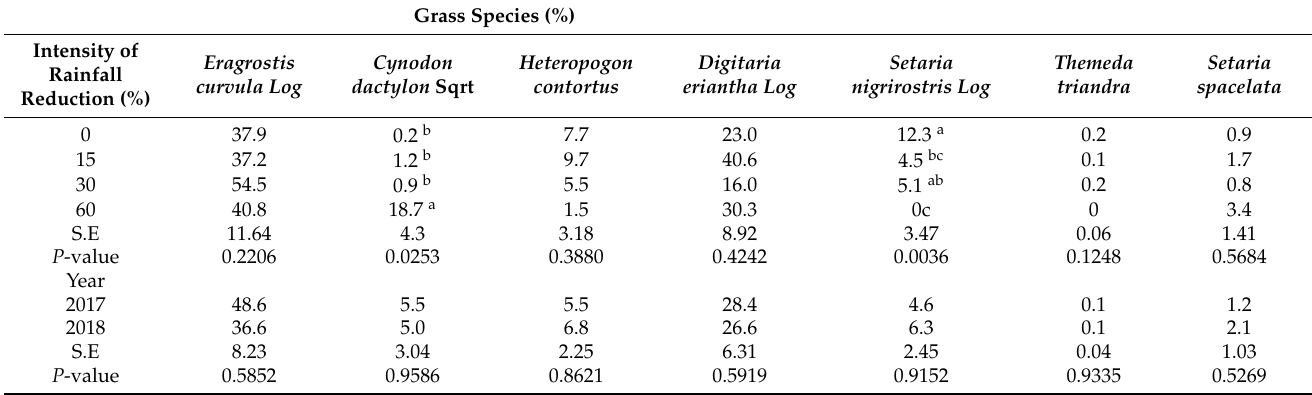
Table 4. Percentage species contribution on grass ANPP of the semiarid grassland as affected by different intensity of rainfall reduction (RR) in